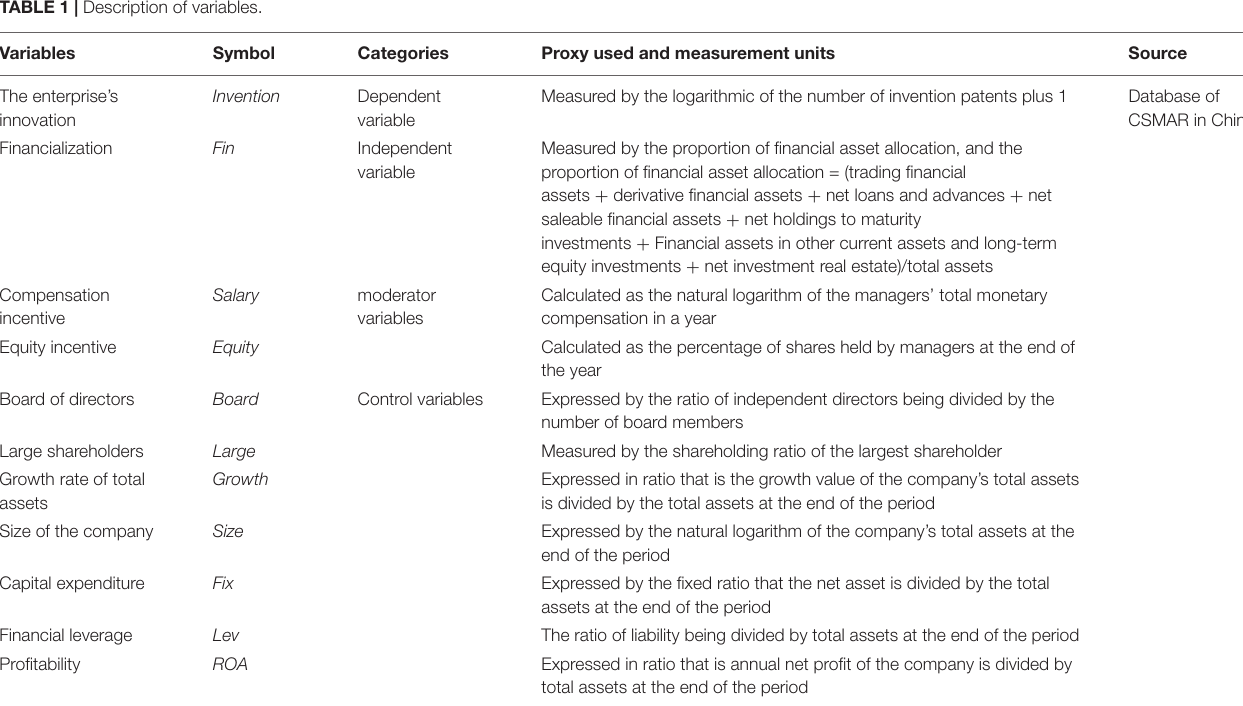
FIGURE 1 | Research model. Dotted lines show a moderating relationship and solid lines indicate a direct relationship. TABLE 1 | Description of